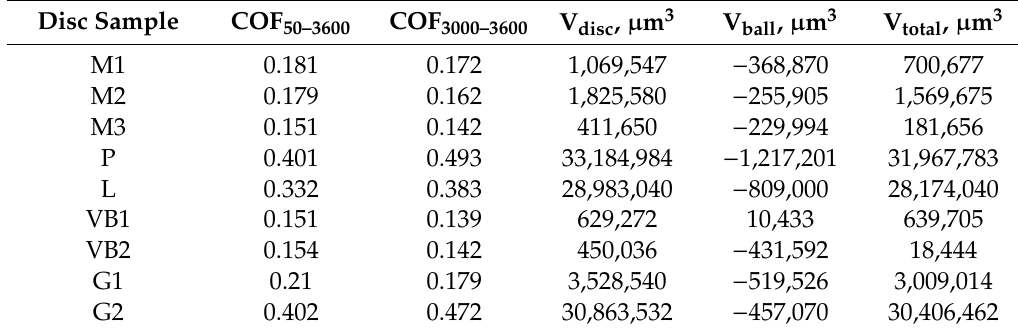
Table 5. Results of test B1 (f = 80 Hz, P = 45 N, temperature 90 ◦ C, number of cycles 288,000). Disc